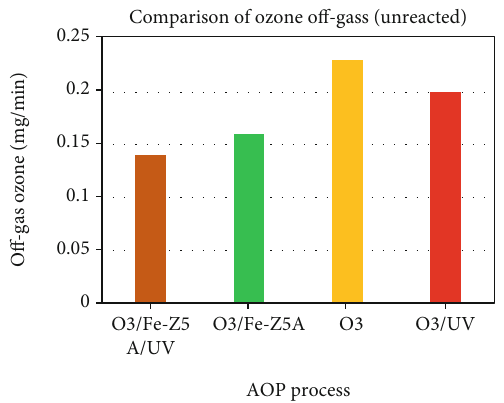
Figure 6: Comparison of AOPs for o ff -gas measured from KI traps during the removal of cipro fl oxacin ( C o ð = 0 : 9 mg/L ; volume = 2 : 5 L ; catalyst dose = 25 g : T = 60 ± 0 : 2 ; O 3 min ).